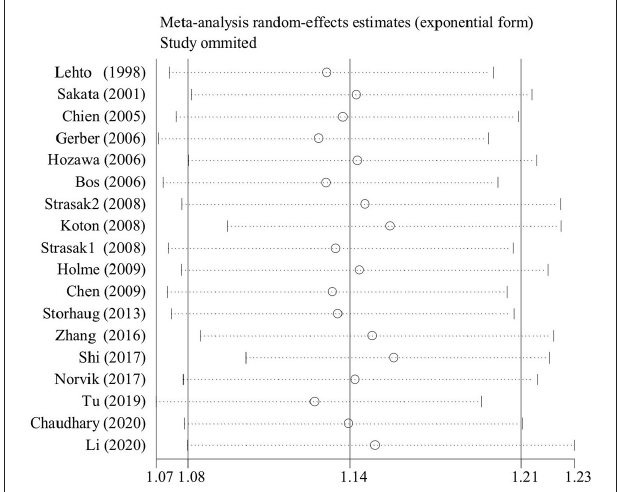
FIGURE 2 | The sensitive plot on the association of uric acid levels and risk of stroke with the exclusion of lower-quality studies.